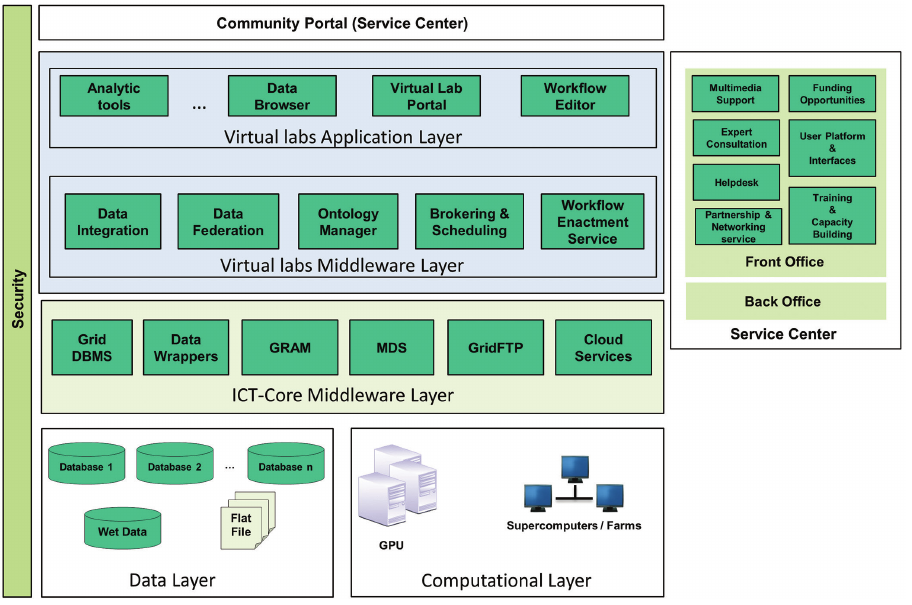
Figure 1. LifeWatch architecture in